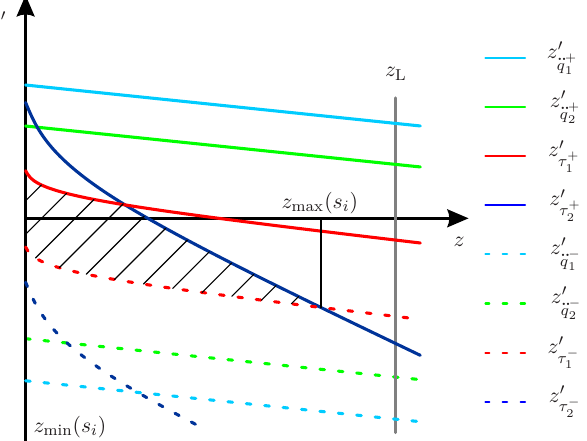
Figure 3. Graphical illustration of technical restrictions in the z × z (cid:48)